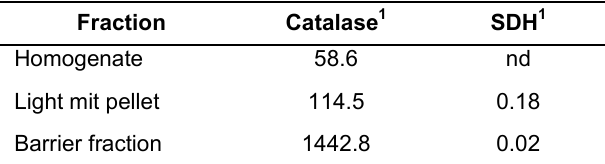
Enzyme Analysis of